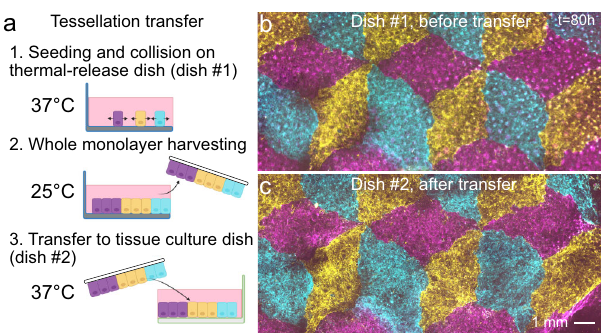
Fig. 4 Transfer of intact tissue tessellations. a Schematic of the tissue tessellation transfer process. A support membrane (white) facilitates cell sheet removal and transfer at room temperature from cell culture-ware with temperature-switchable cell adhesion (UpCell). Created with Biorender.com. b , c Tessellation on UpCell dish ( b ) is transferred to standard tissue-culture dish ( c ). Four independent tessellation transfers were performed with qualitatively similar results.